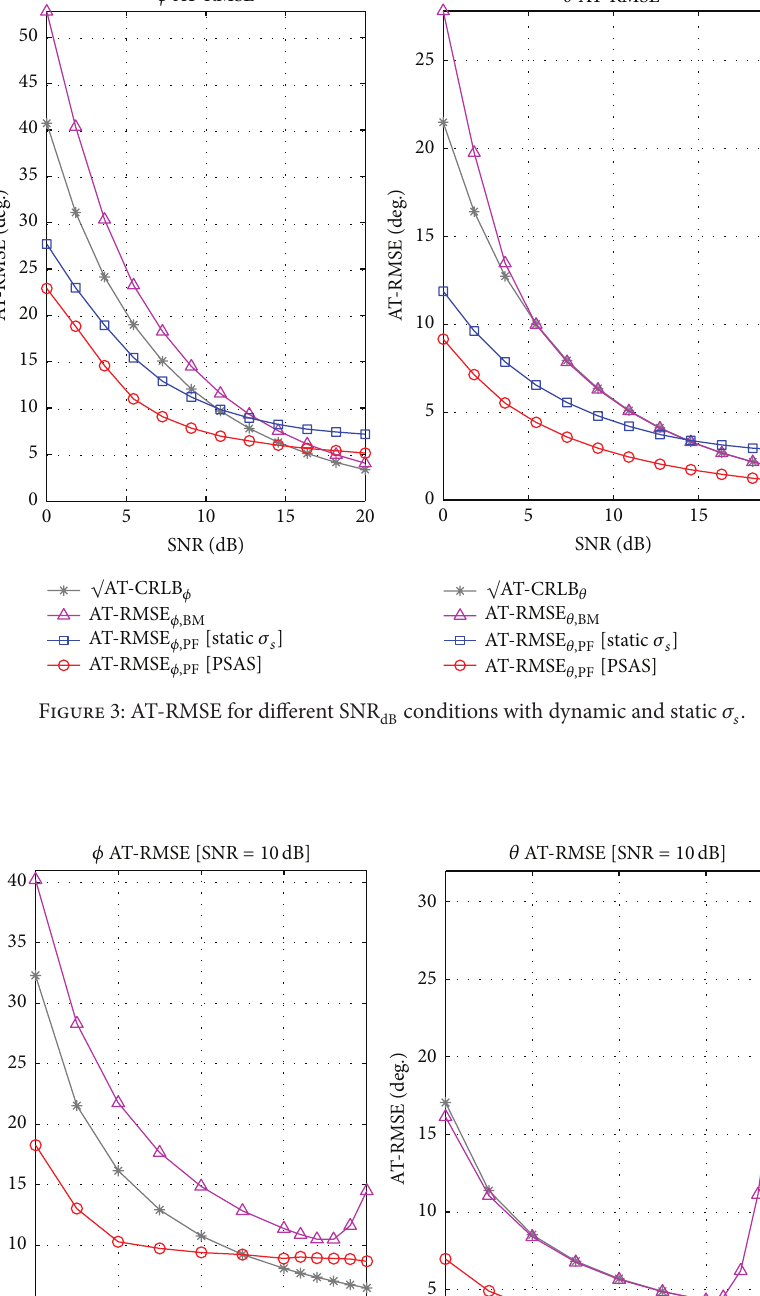
Figure 4: AT-RMSE for different normalized 3A-ULA interantenna distance 𝐷